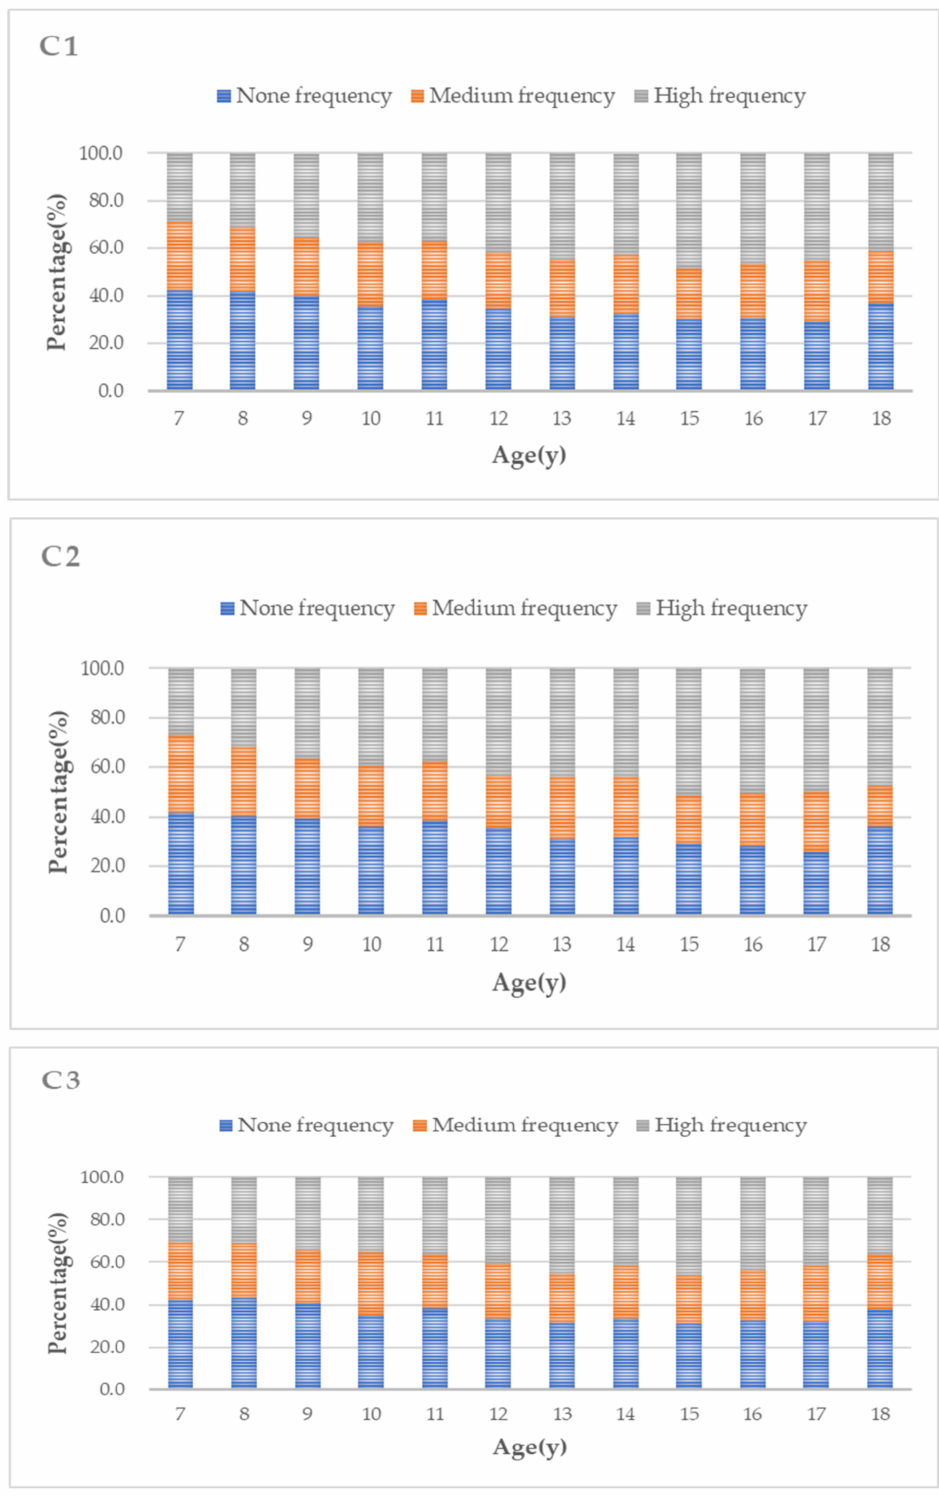
Figure 1. Soy food intake in Chinese children and adolescents according to age 1 for total, 2 for males and 3 for females; ( A1 – A3 ) present data on liquid soy food; ( B1 – B3 ) present data on solid soy food; ( C1 – C3 ) present data on the intake frequency of all soy food. ( A1 , B1 , C1 ) show data for the total population; ( A2 , B2 , C2 ) show data for the boys; ( A3 , B3 , C3 ) show data for the